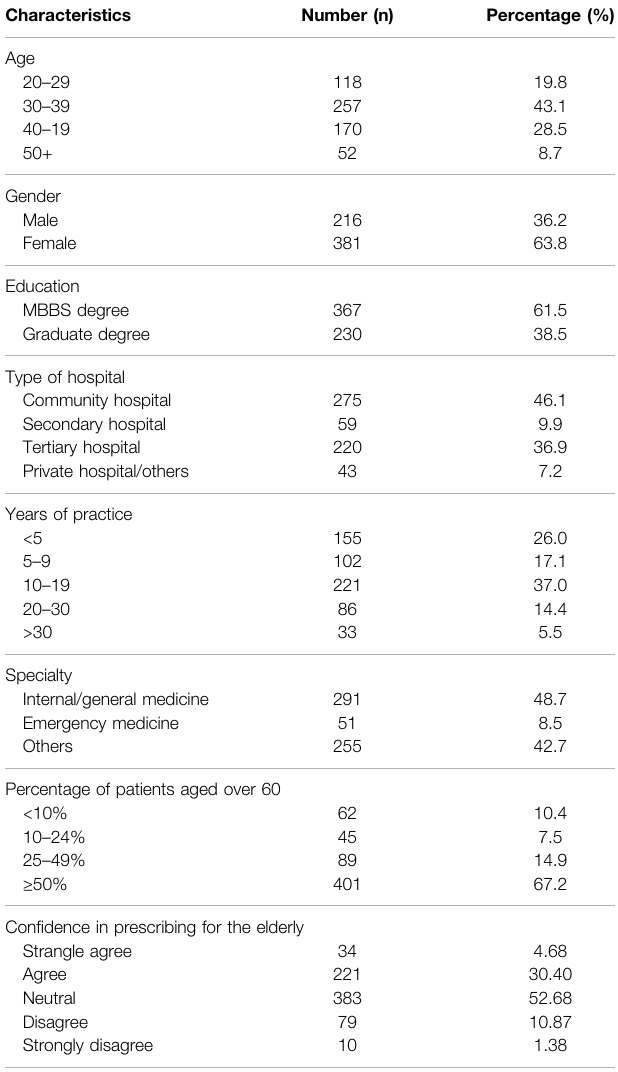
TABLE 1 | Self-reported characteristics of physicians who participated in the